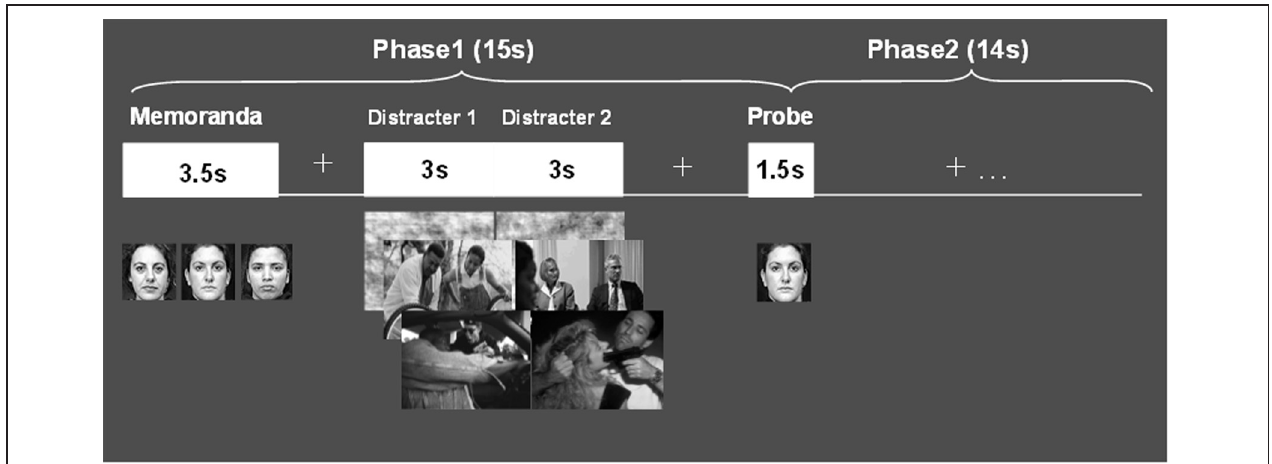
FIGURE 2 | Delayed-response WM task with emotional distraction. The memoranda consisted of human faces, which participants encoded and maintained into WM. After a short delay, a probe was presented and subjects had to decide whether it was part of the memoranda or not. During the delay